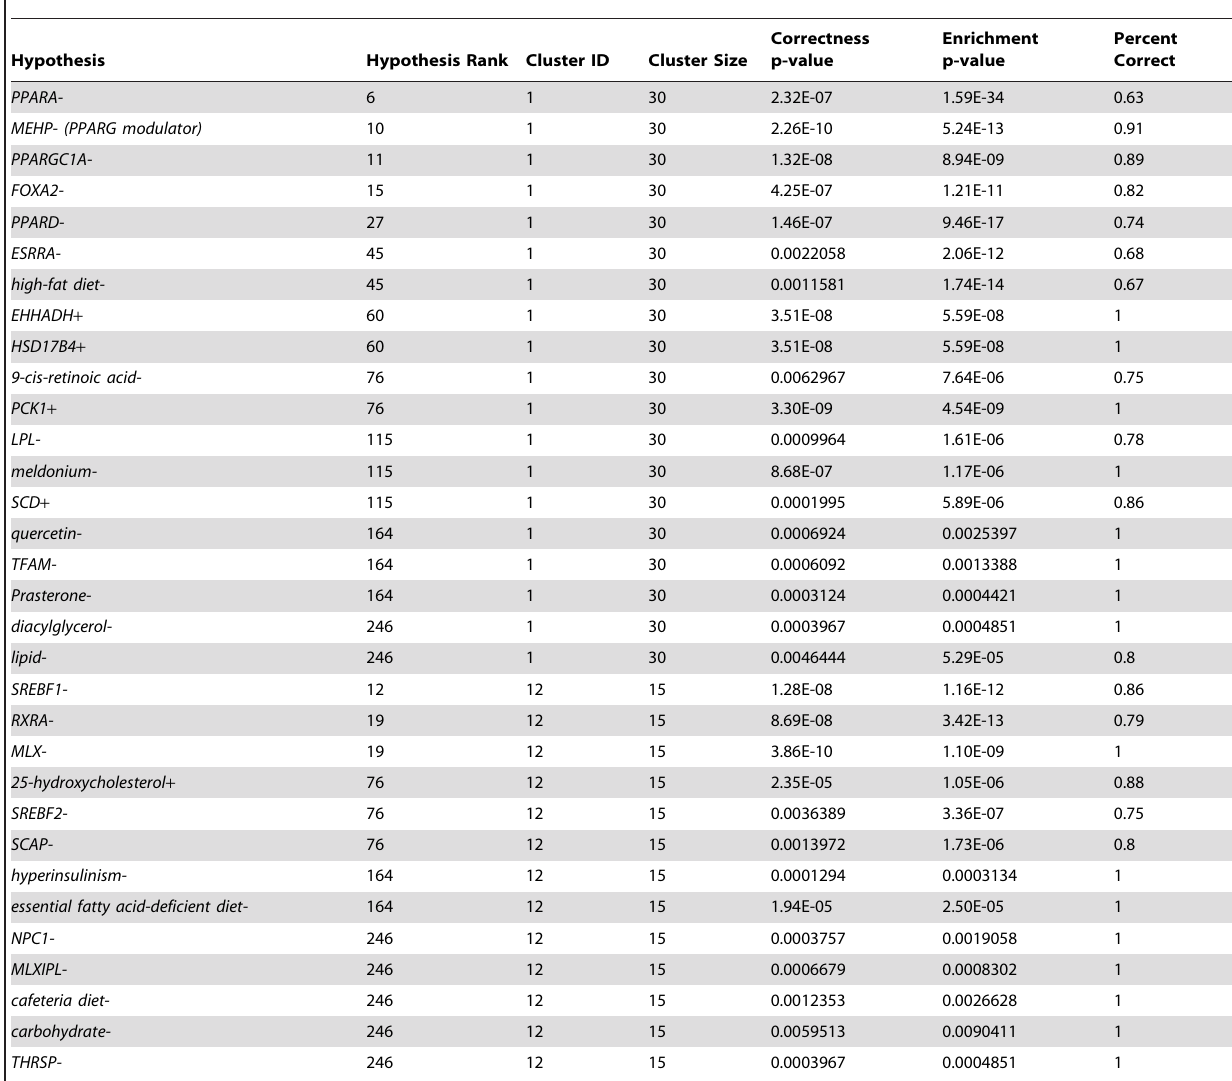
Table 4. Top two clusters for the high dose at cluster threshold 0.15 after excluding redundancies.